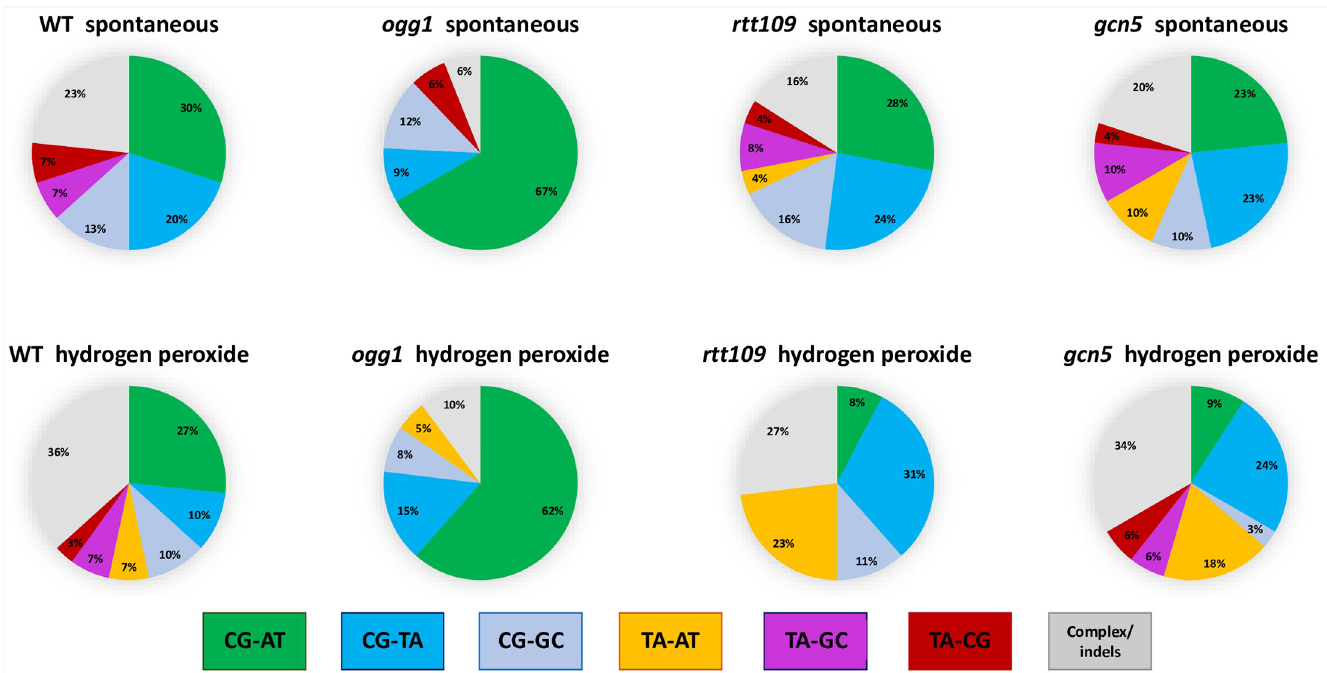
Fig 6. Mutation spectra at CAN1 locus in dsDNA. Spectra of spontaneous and hydrogen peroxide–induced mutations for all genotypes analyzed. See also S1 Data. dsDNA, double-stranded DNA.